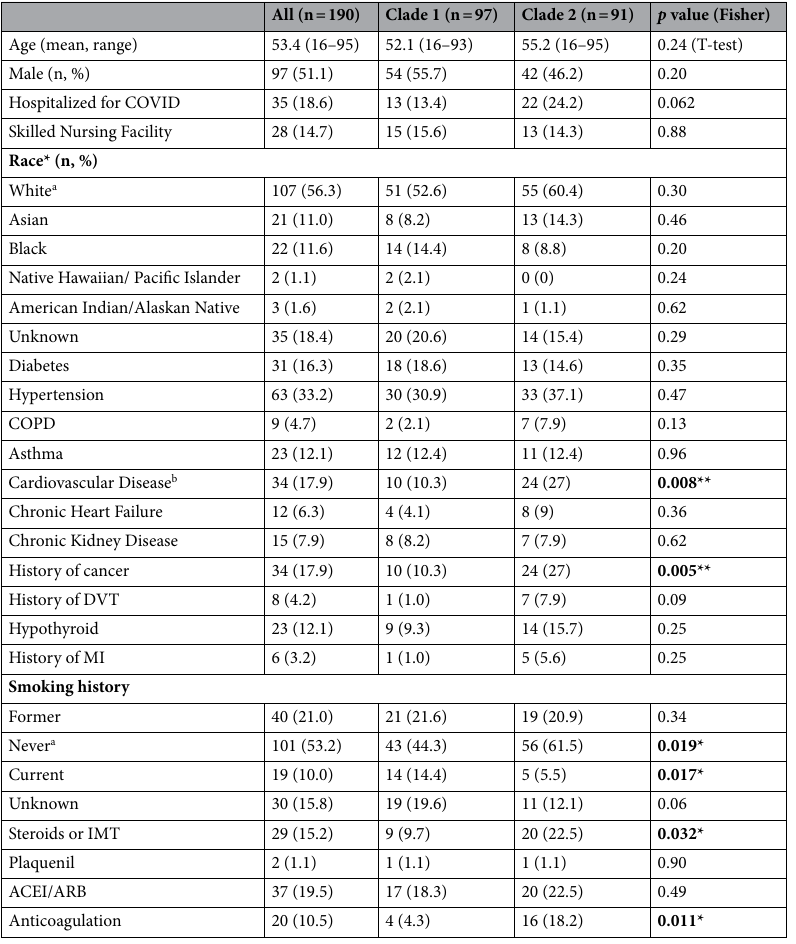
Table 5. Demographic Factors and Baseline Clinical Characteristics of the Study Population Stratified by Viral Clade (n = 188) a . a Reference value. b Cardiovascular disease defined as history of MI, CVD/stroke, CHF, valvular diseases (s/p CABG). All diseases were defined using ICD-9 and ICD-10 codes. DVT Deep Venous Thrombosis, COPD chronic obstructive pulmonary disease, MI myocardial infarction, ACEI angiotensin- converting enzyme inhibitors, ARB angiotensin receptor blocker, IMT immunomodulatory